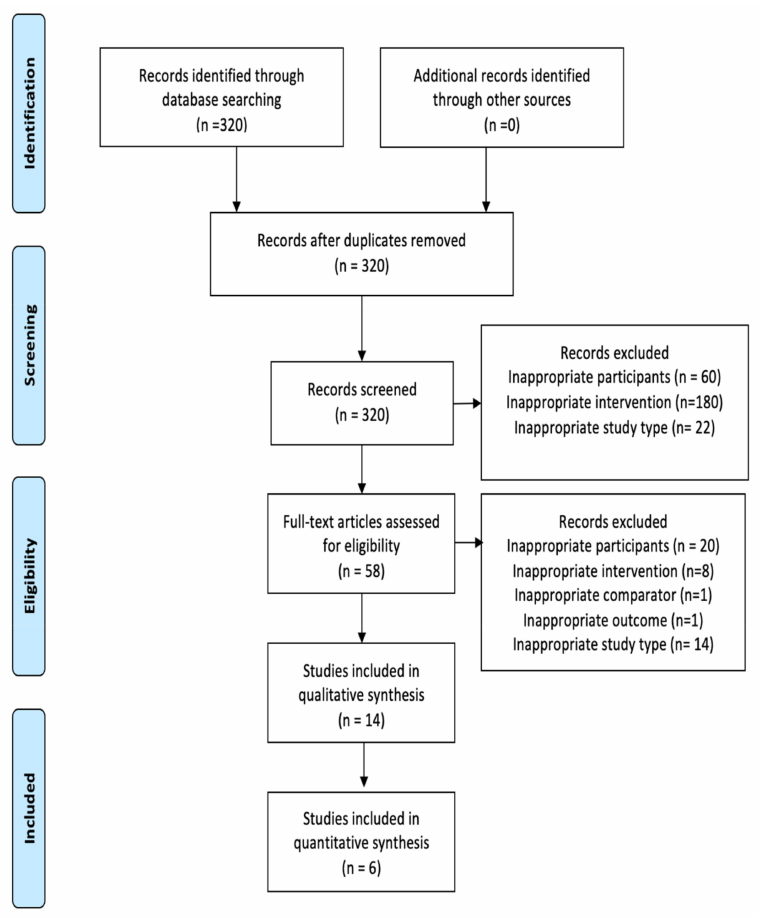
Figure 1. Flow diagram of the systematic